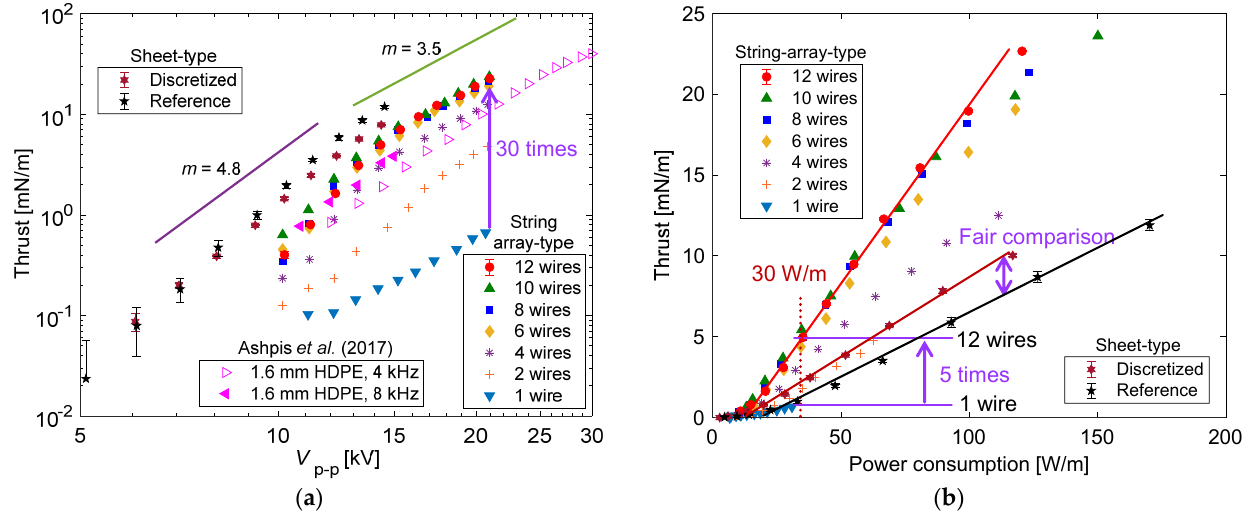
Figure 4. Thrust as a function of ( a ) V p-p compared with the data obtained by Ashpis et al. [21]; ( b ) P PA . At 30 W/m, the thrust of the string-array-type PA with eight or more wires increased by approximately five times, as compared with that of the string-type PA with a single wire.